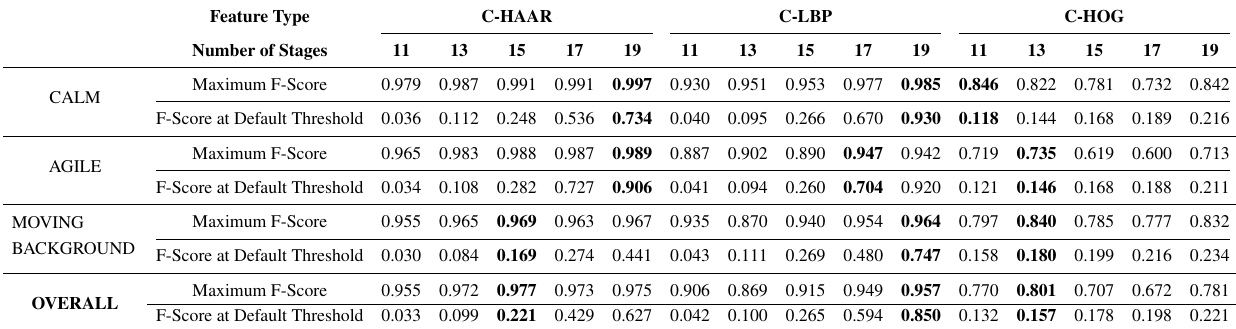
Table 4. Performance of the methods outdoors, reported as F-score values. Bold indicates best